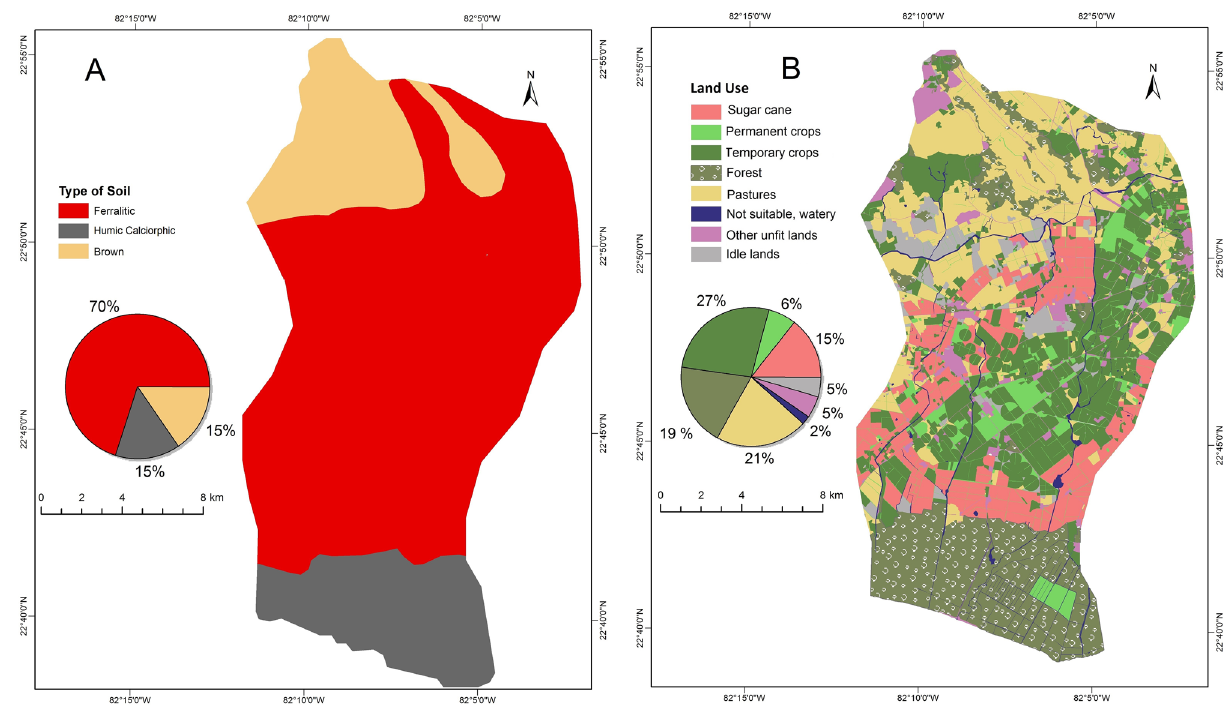
Fig. 5 A Soil distribution1 [50] and B conditions of uses in the basin